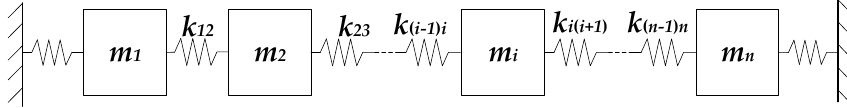
Figure 1. n-degree-of-freedom undamped vibration system.